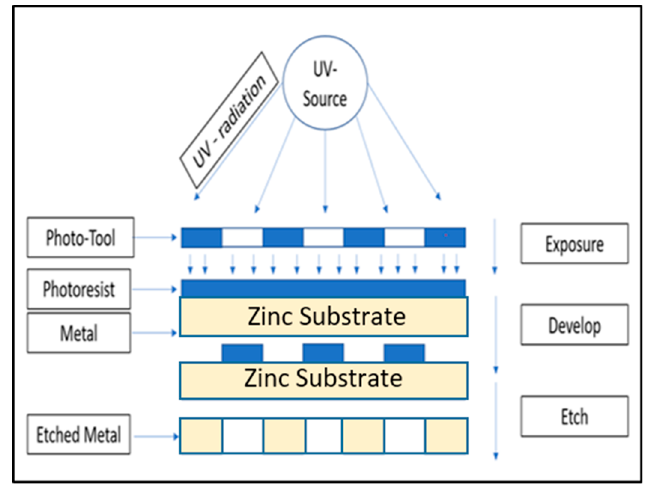
Figure 1. Illustration of the photo-chemical etching method for fabricating metal stents.